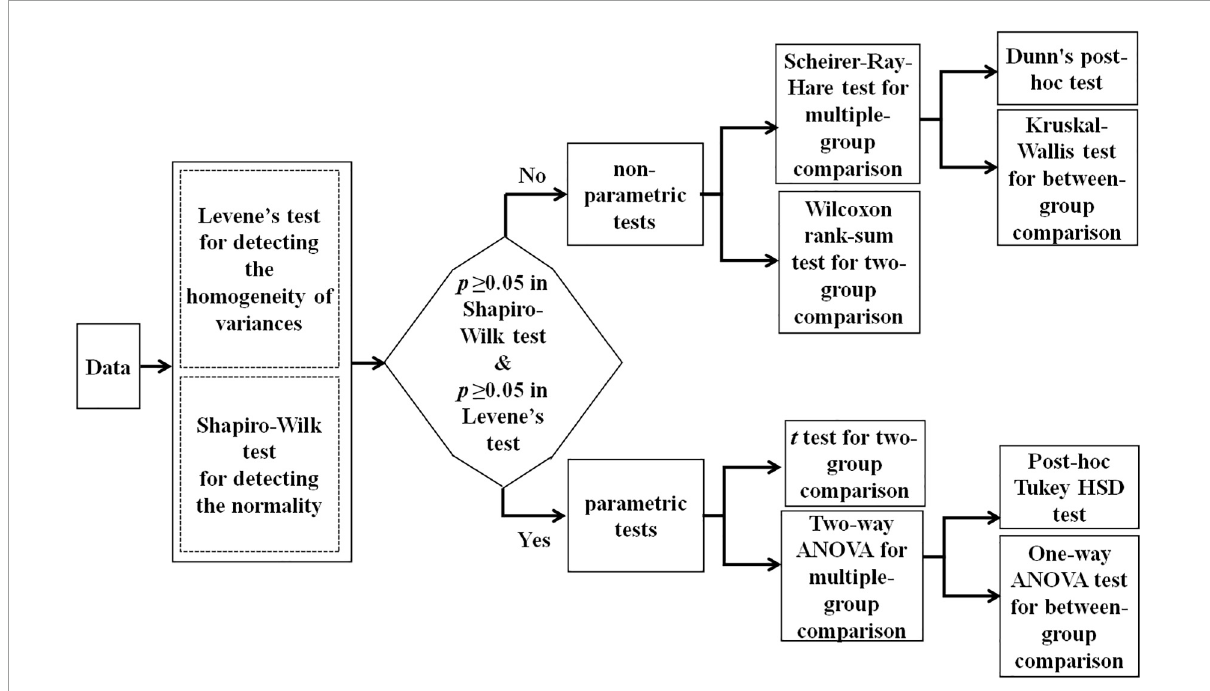
FIGURE2 The flowchart of statistical